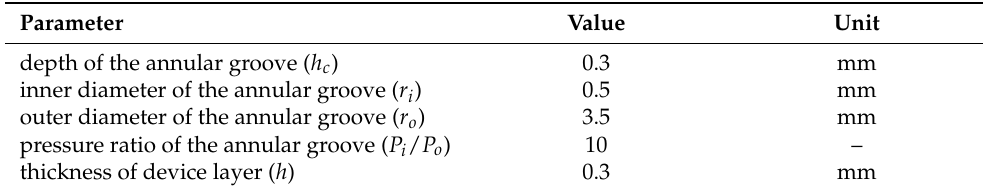
Table 1. Material parameters of fused silica. Parameter Value Unit Young’s modulus 70 GPa Poisson’s ratio 0.17 – Density 2200 kg/m 3 Thermal conductivity 1.4 W/(m · K) Specific heat capacity 730 J/(kg × K) Coefficient of thermal 5 × 10 − 7 1/K expansion